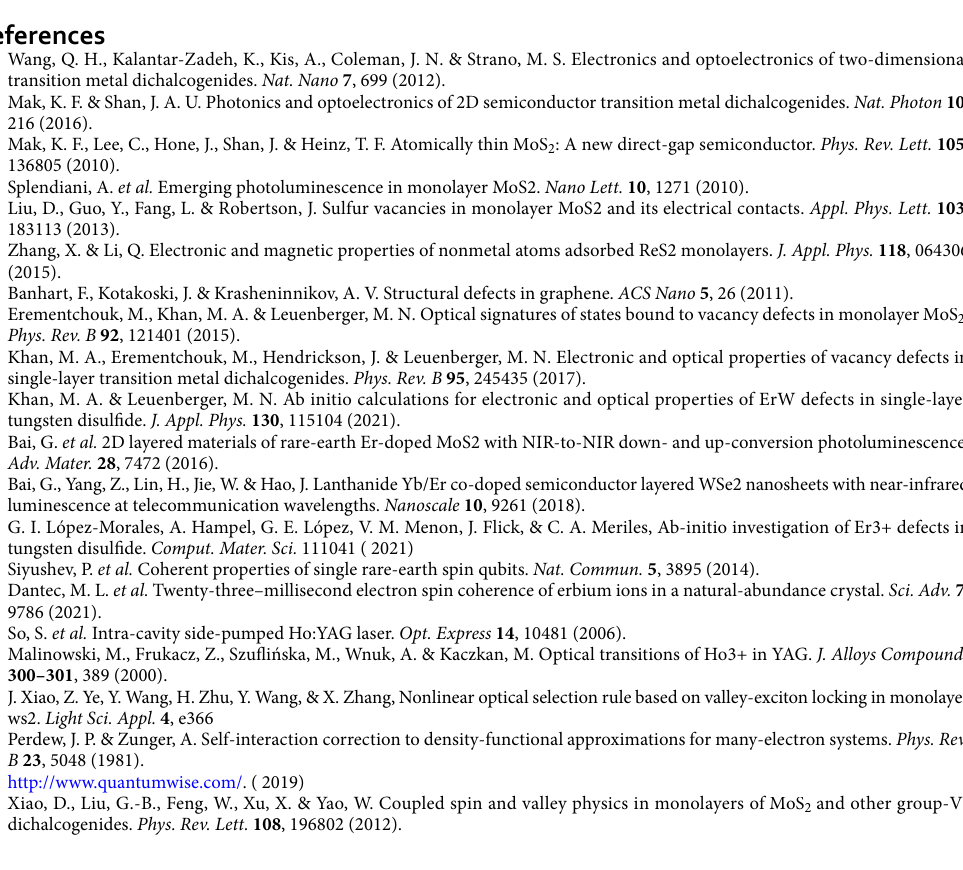
Figure 7. Optical spectrum calculated by means of ATK showing resonances of Im ε (ω) (red) a ) due to Ho W impurities in WS 2 Im [ ⊥ ]